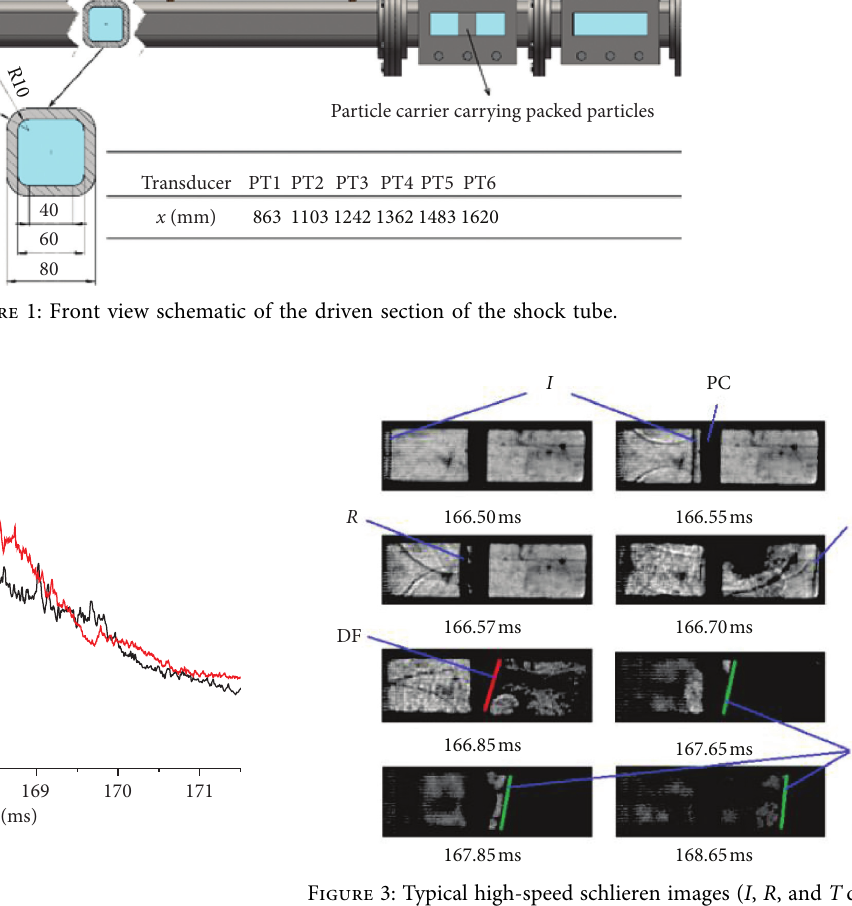
Figure 2: Typical pressure histories at the two side of the particle wall.